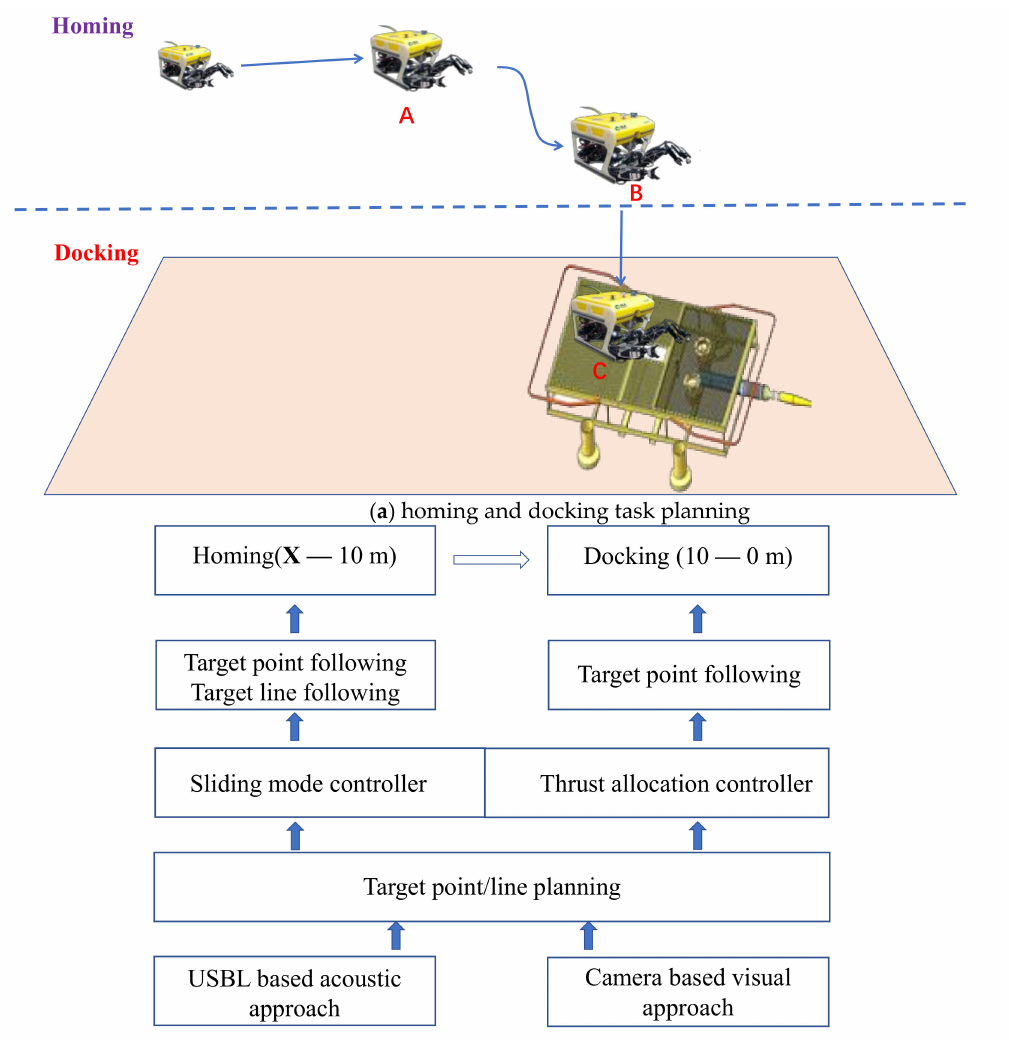
Figure 1. Sketch of homing and docking